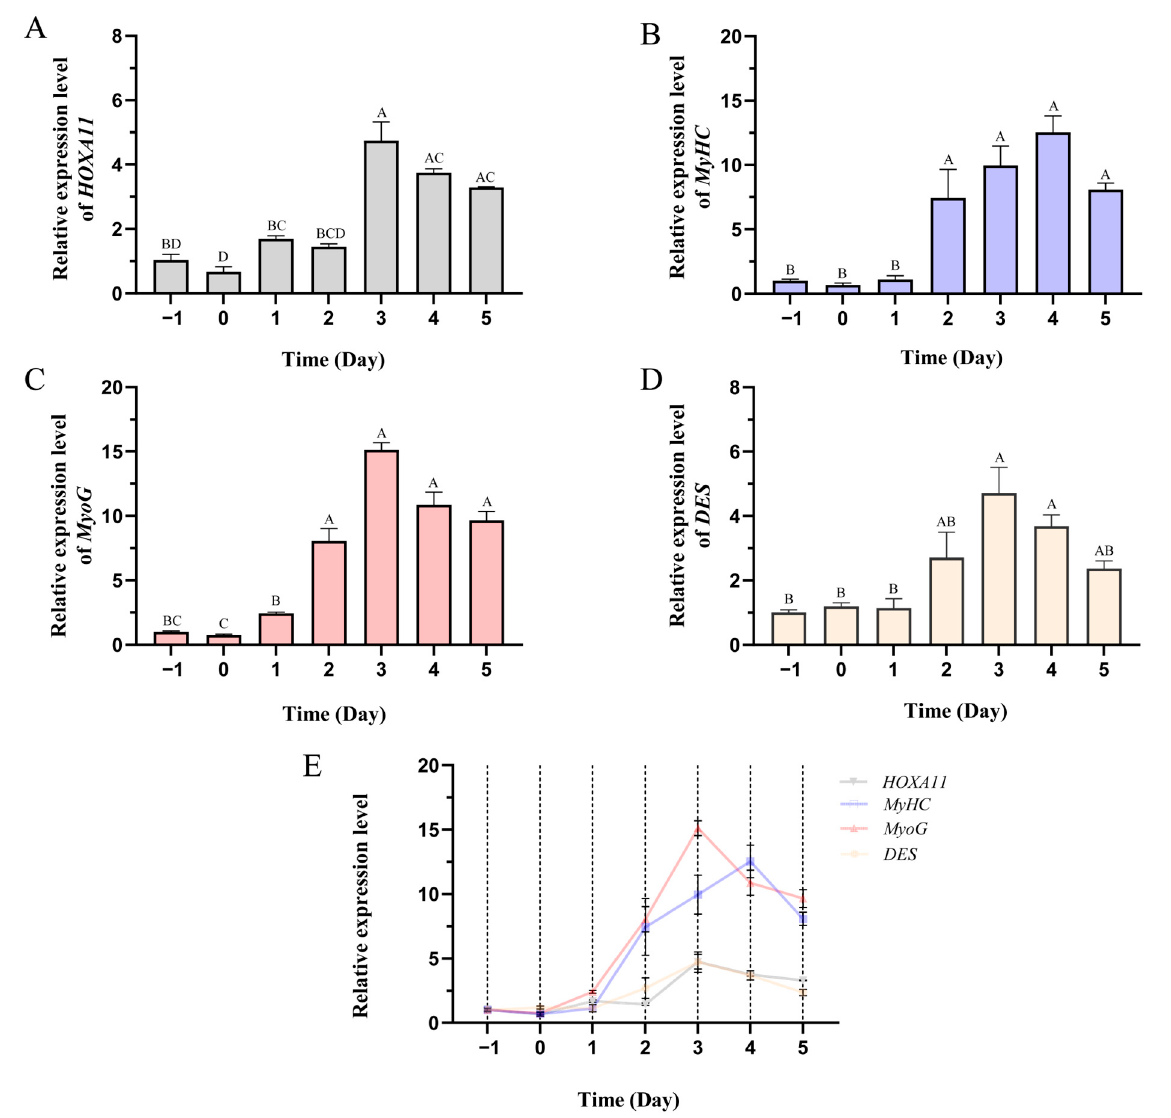
Figure 5. Expression characteristics of HOXA11 and muscle-development-associated genes in bovine myoblasts. Expression trend of HOXA11 ( A ), MyHC ( B ), MyoG ( C ) and DES ( D ) in bovine myoblasts cultured in proliferation medium ( − 1 day) and differentiation medium (0, 1, 2, 3, 4 and 5 days; n = 3), and the expression trend line chart of these genes ( E ). The columns with different superscripts ( A – D ) within each figure differ significantly at p < 0.01 level. Bars represent mean, error bars represent standard error of mean (SEM).